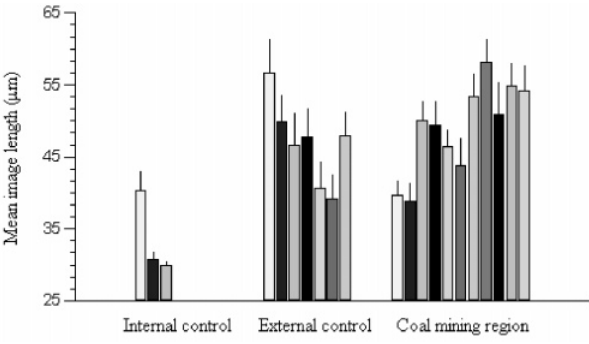
Figure 2 - Mean comet tail length ( – SD) in rodents from Pelotas (external control) and Candiota (coal mining region) and for human blood (internal control). Each column represents one